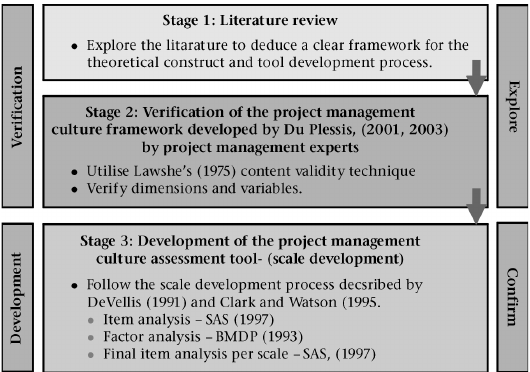
Figure 2: Research Design and